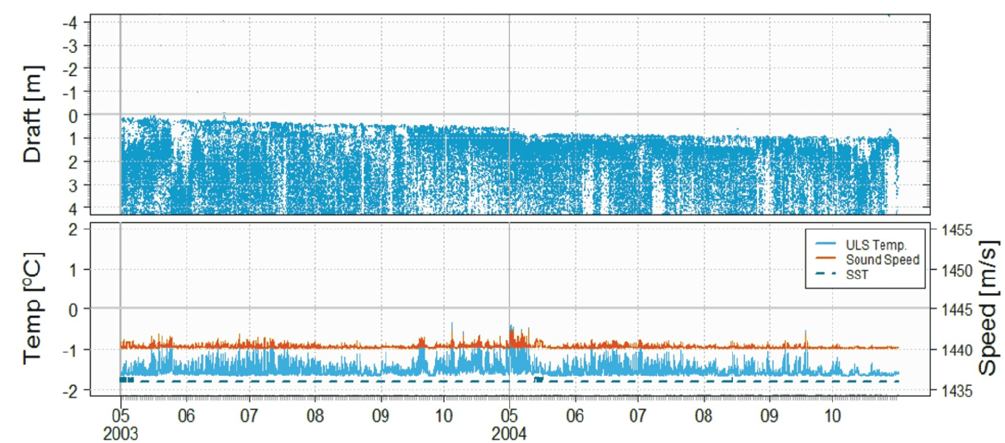
Figure 10. Upper panel: draft data of AWI 233-6 in the winters 2003 and 2004, corrected with the sound speed model. The e ff ect of pressure drift is evident in the draft record. It results in an apparent change in ice draft of about 1m over almost 1.5yr. Lower panel: temperature at the ULS, sea surface temperature, and sound speed calculated with the model. Since the ULS temperature is always close to the freezing point, the vertical sound speed profile above the ULS is constant. This results in an almost constant vertical mean sound speed of about 1440ms − 1 . The linear change in ice draft can therefore not be explained by changes in the sound velocity and is interpreted as pressure drift.